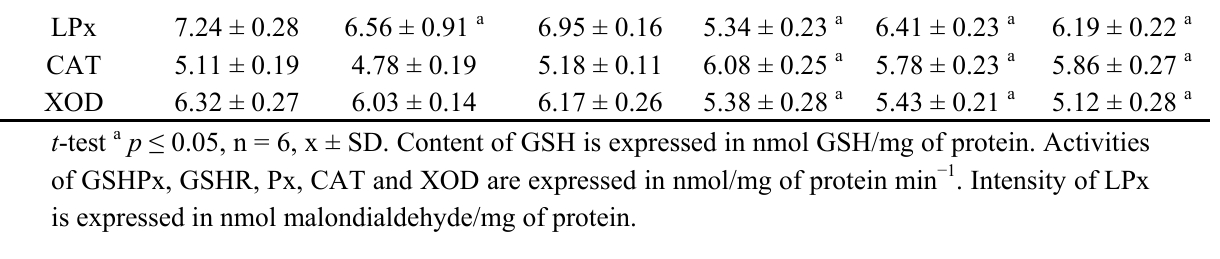
Table 4. Effect of extracts of T. pratense leaves on the biochemical parameters in blood hemolysate. Parameter